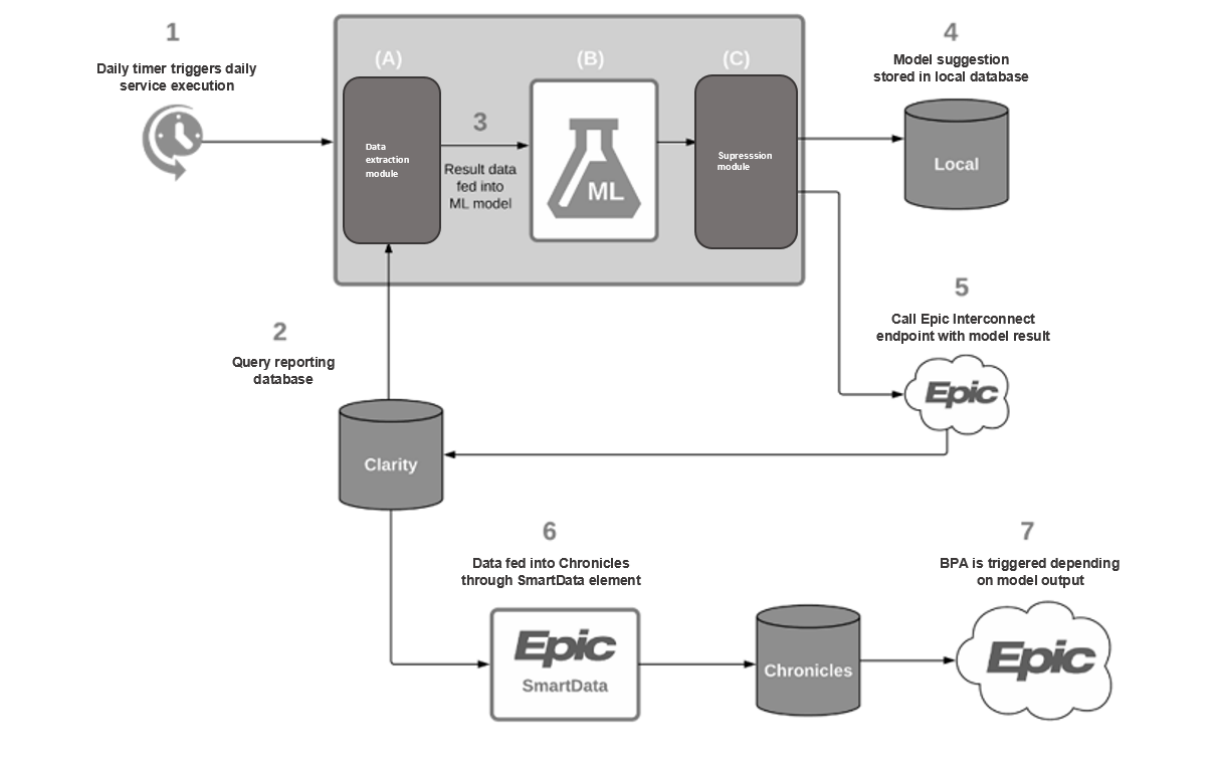
Figure 3. SmartCDS system architecture. This illustrates the SmartCDS machine learning (ML) implementation flow. (1) A timer (Cron job) is configured to run every day and invoke the SmartCDS service. (2) The data extraction module will query the reporting database (Epic Clarity) and feed (3) encounter, provider, user demographic, and best practice advisory data to the ML model. (4) The model output is then both stored in a local database for further analysis and pushed (5) to Epic through an Epic Interconnect Web Services endpoint. From here, information about what alert per encounter should be suppressed is written (6) into the Epic event database (Chronicles) through a SmartData element. An alert rule will inspect (7) these data to allow or suppress the alert being fired. BPA: best practice advisory; ML: machine